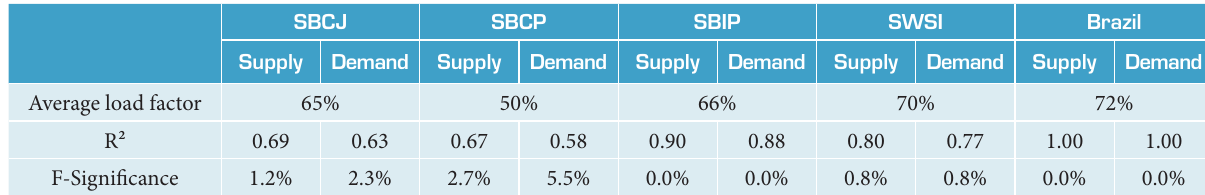
Table 3. Summary of the regression analysis